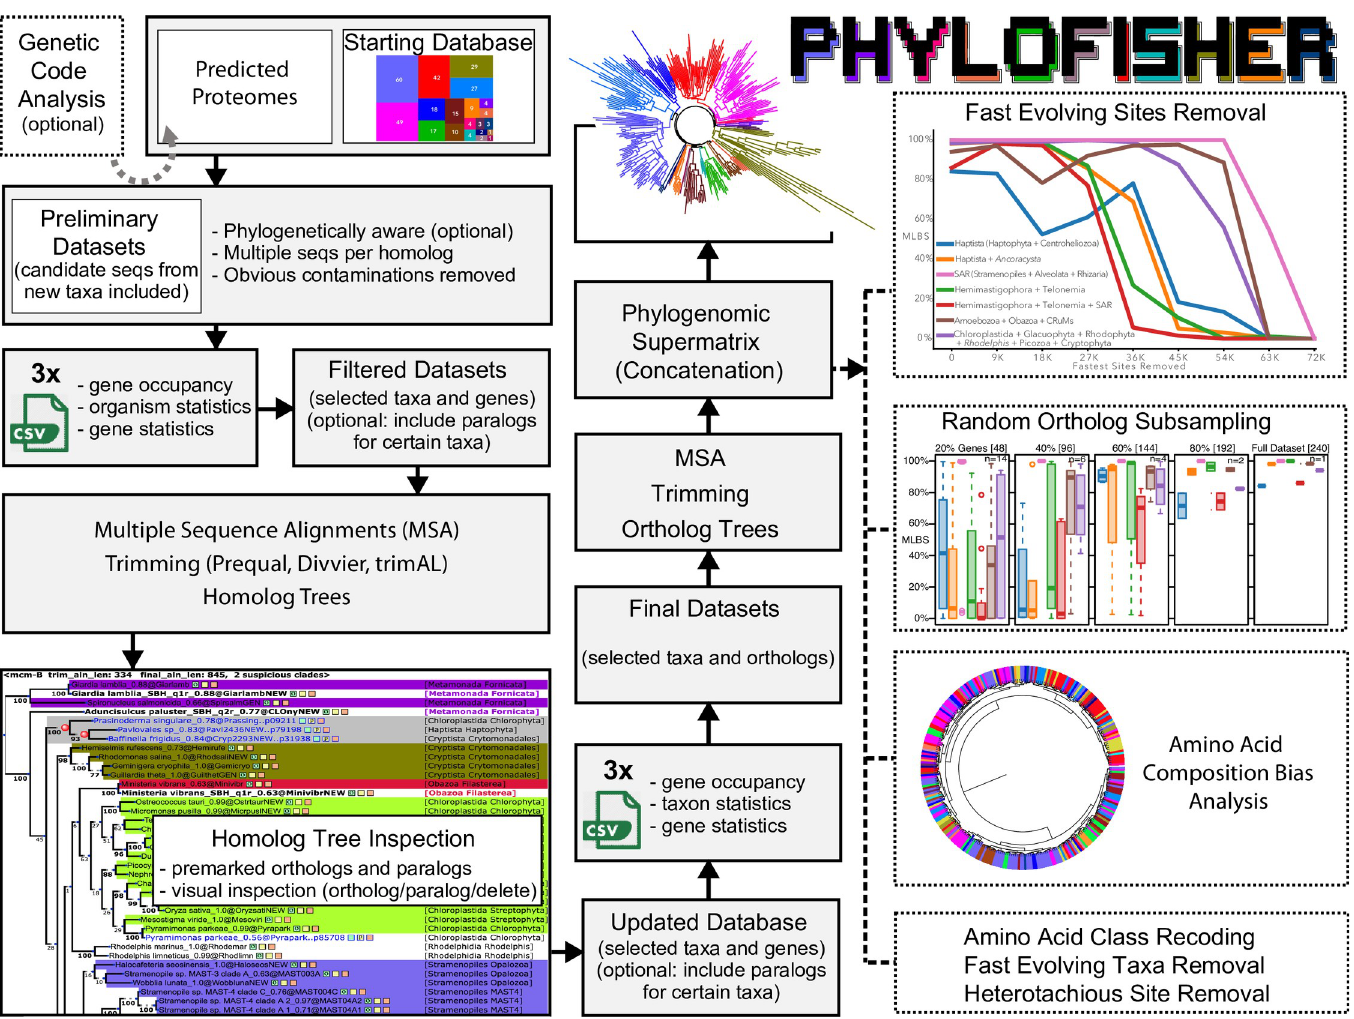
Fig 1. Overview of the PhyloFisher workflow and package contents. The PhyloFisher package consists of a manually curated starting database of 240 protein-coding genes and their paralogs from 304 eukaryotic taxa; a series of tools to perform the essential steps of phylogenomic dataset construction (homolog collection, single-protein tree construction, removal of paralogs and contaminants, and matrix concatenation); and many pre- and post-construction analyses necessary for a publication-quality phylogenomic